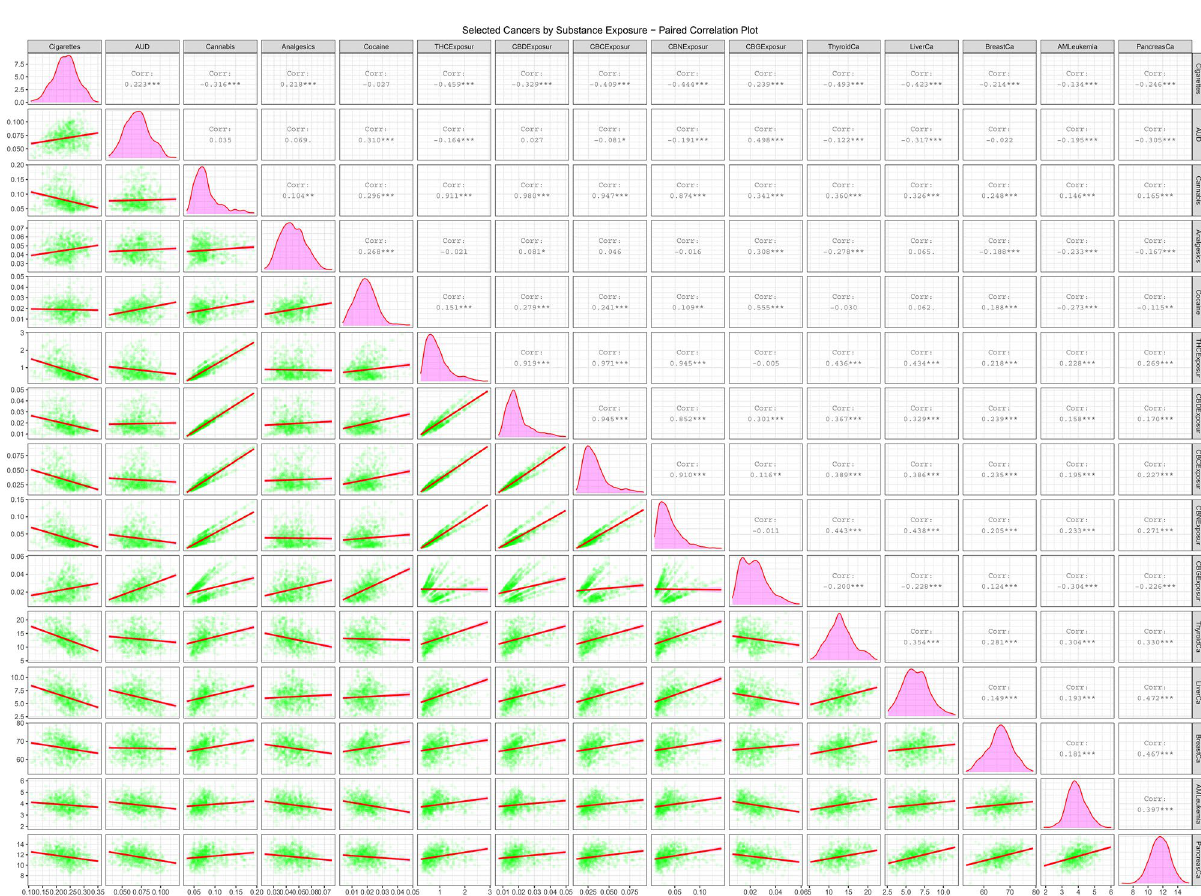
Figure 5. Paired scatterplot matrix for the covariates in the cancer dataset. (Created in R-Studio version 1.3.1093 using ggpairs function from the GGally package version 2.0.0).